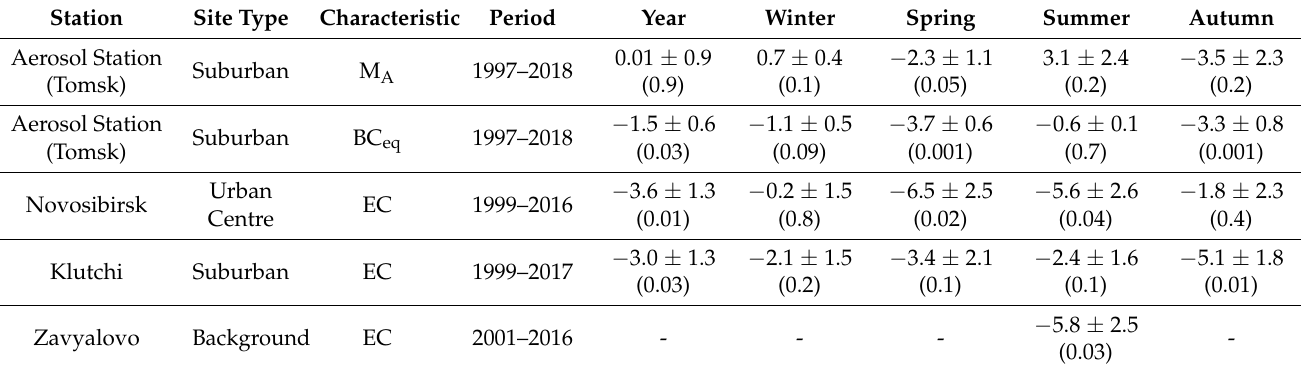
Figure 8. Multiyear behavior, SD, and trends of annual average mass concentrations of ( a ) submicron aerosol and ( b ) black carbon at the Aerosol Station (suburban) in 1997–2018. Blue shadings show SD of total dataset of ( a ) mass concentrations of submicron aerosol. Gray shadings show SD of total dataset of ( b ) mass concentrations of black carbon. Open diamonds indicate concentrations without accounting for the contributions from situations with wildfires. Table 3. Trends (% per year) of the concentrations M A , BC eq , EC ( µ g/m 3 ) and their errors and significance ( p -value), given in parentheses, at different